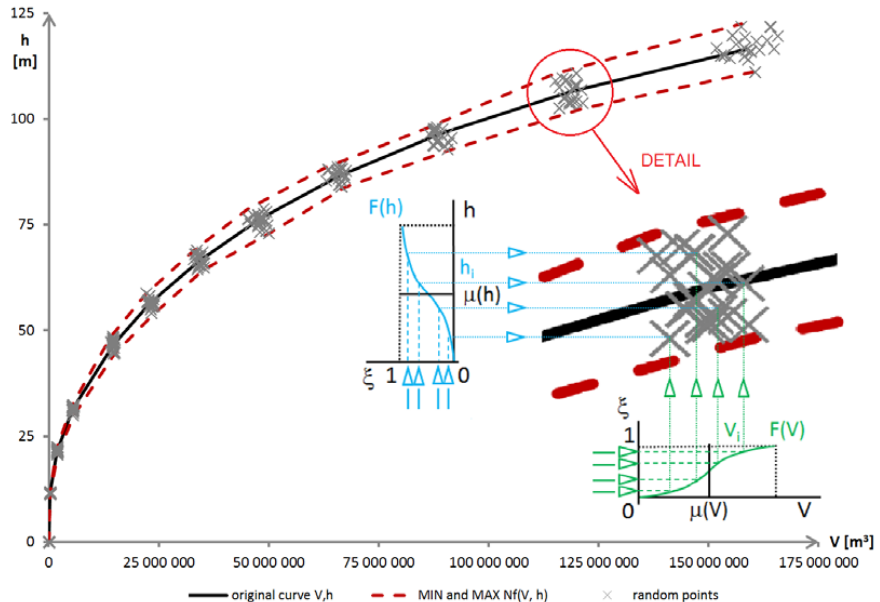
Figure 1. The principle of generating the uncertainty of input elements using the Monte Carlo method. Where V is the volume of water, h is height of the water level, µ (V) is the mean volume value, µ (h) is the mean of the water level, F(V) and F(h) are cumulative distribution functions and ξ is a random number ranged in the interval (cid:104) 0,1 (cid:105) .